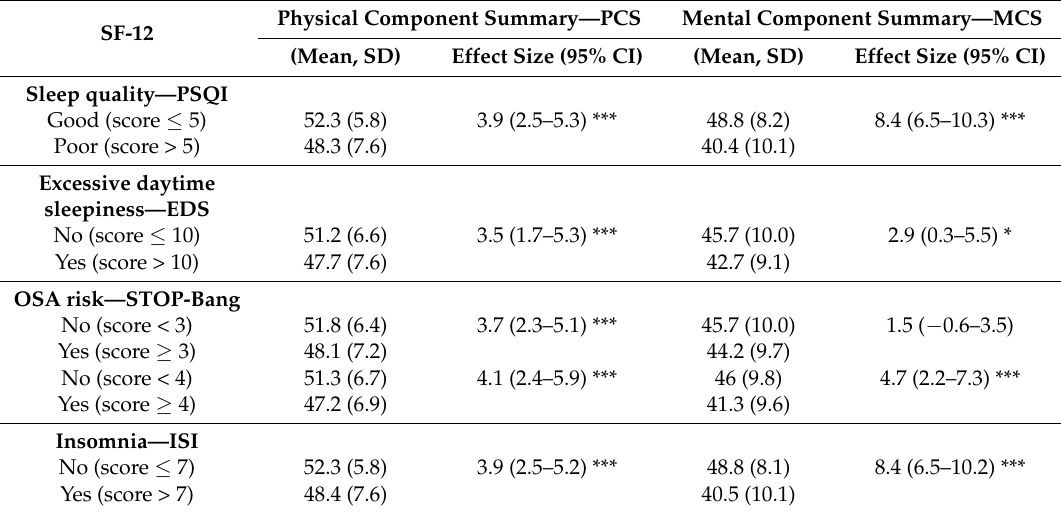
Table 3. Physical and mental component summary scores and effect sizes according to sleep status